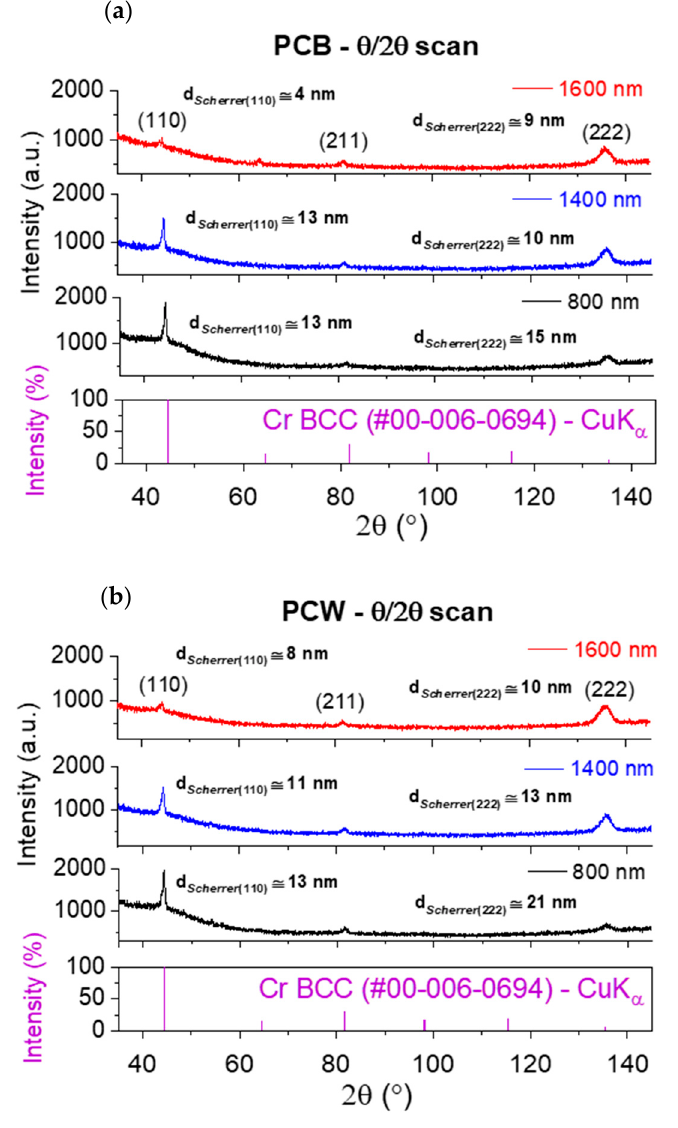
Figure 5. Bragg–Brentano XRD patterns for different thicknesses of Cr films deposited over: ( a ) PCB and ( b ) PCW.